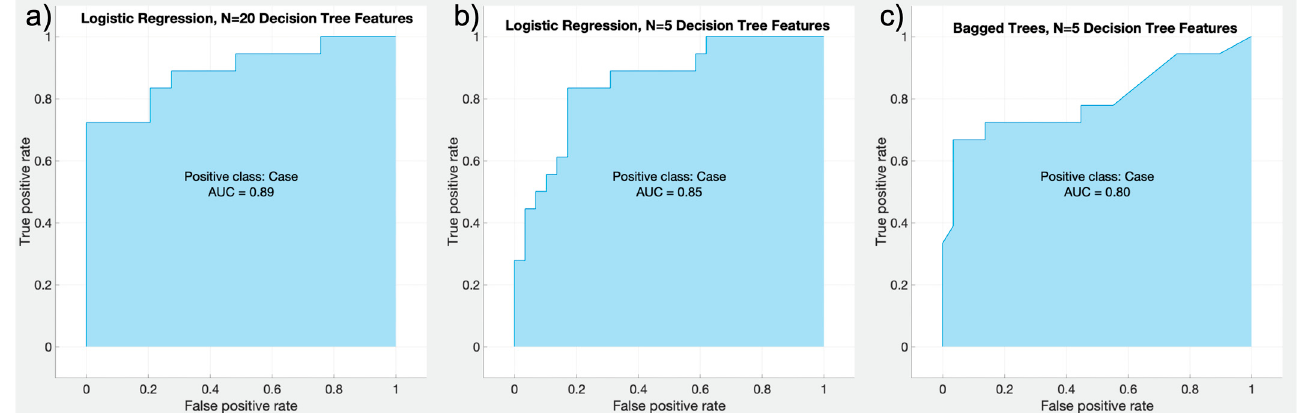
Figure 3. Three models of fracture risk from μ CT images of PSBs tested on 39 datasets, trained from 90 testing and validation datasets. These models are: ( a ) a log-regression model using the top 20 features from a Decision Tree (DT) feature selection process (Table 3), ( b ) a similar log regression model with 5 DT features, and ( c ) a random forest Bagged Trees model with 10 DT features.